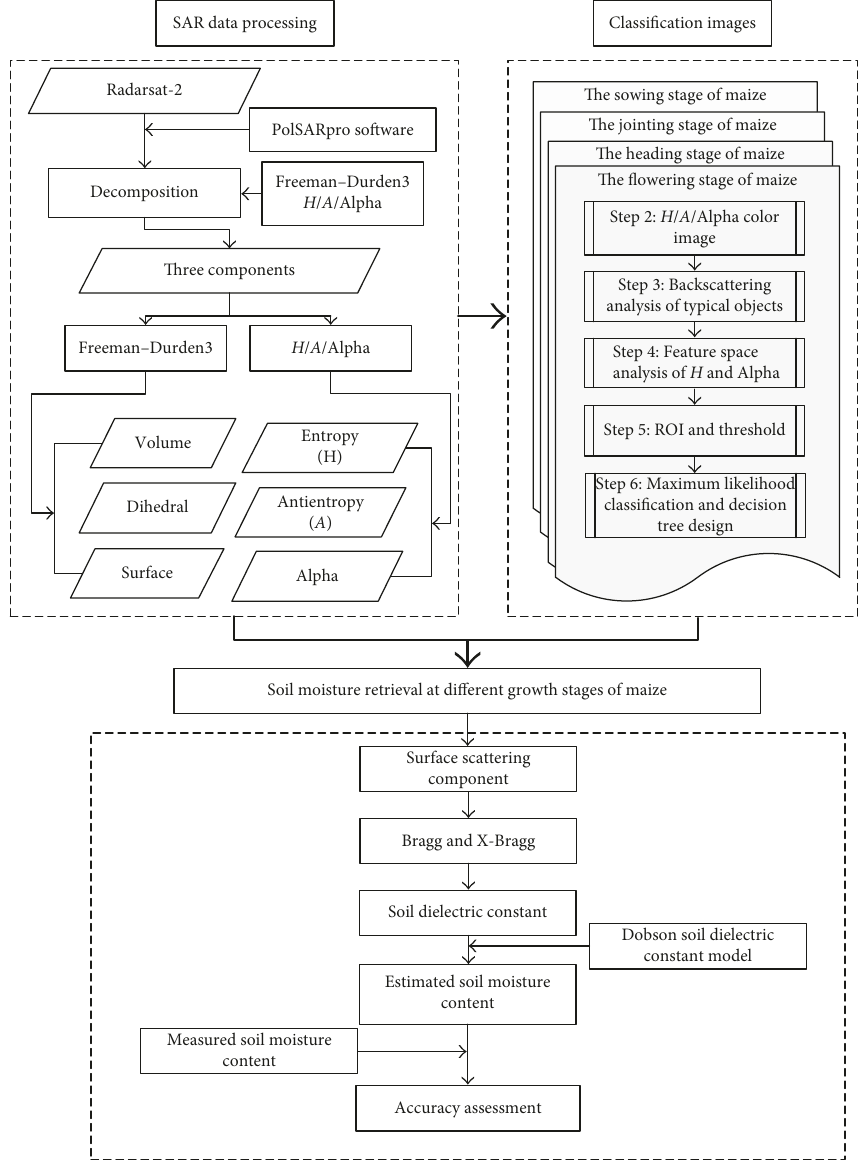
Figure 2: Flowchart of soil moisture content